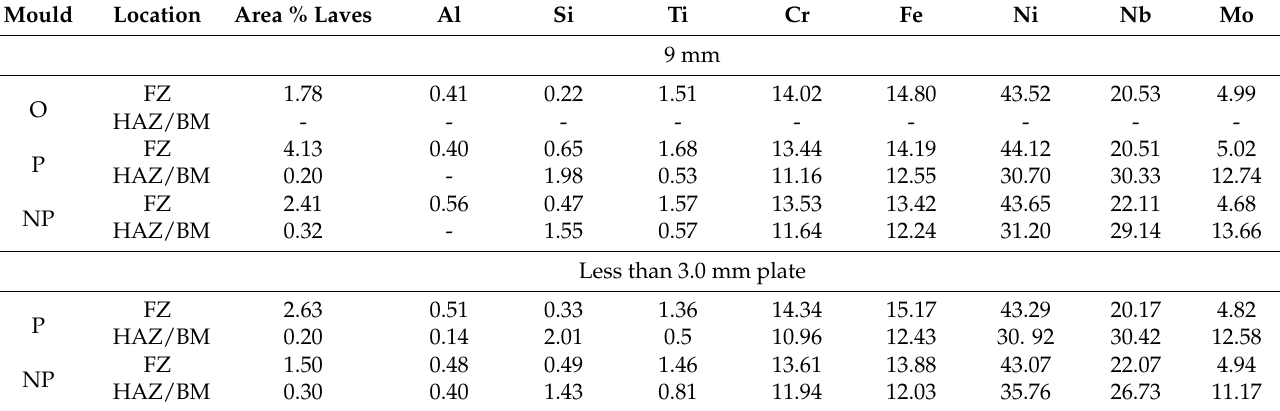
Table 7. Area percentage and mean chemical composition of Laves phase (in wt %) and standard deviation in FZ and HAZ/BM of bead-on-plate welding